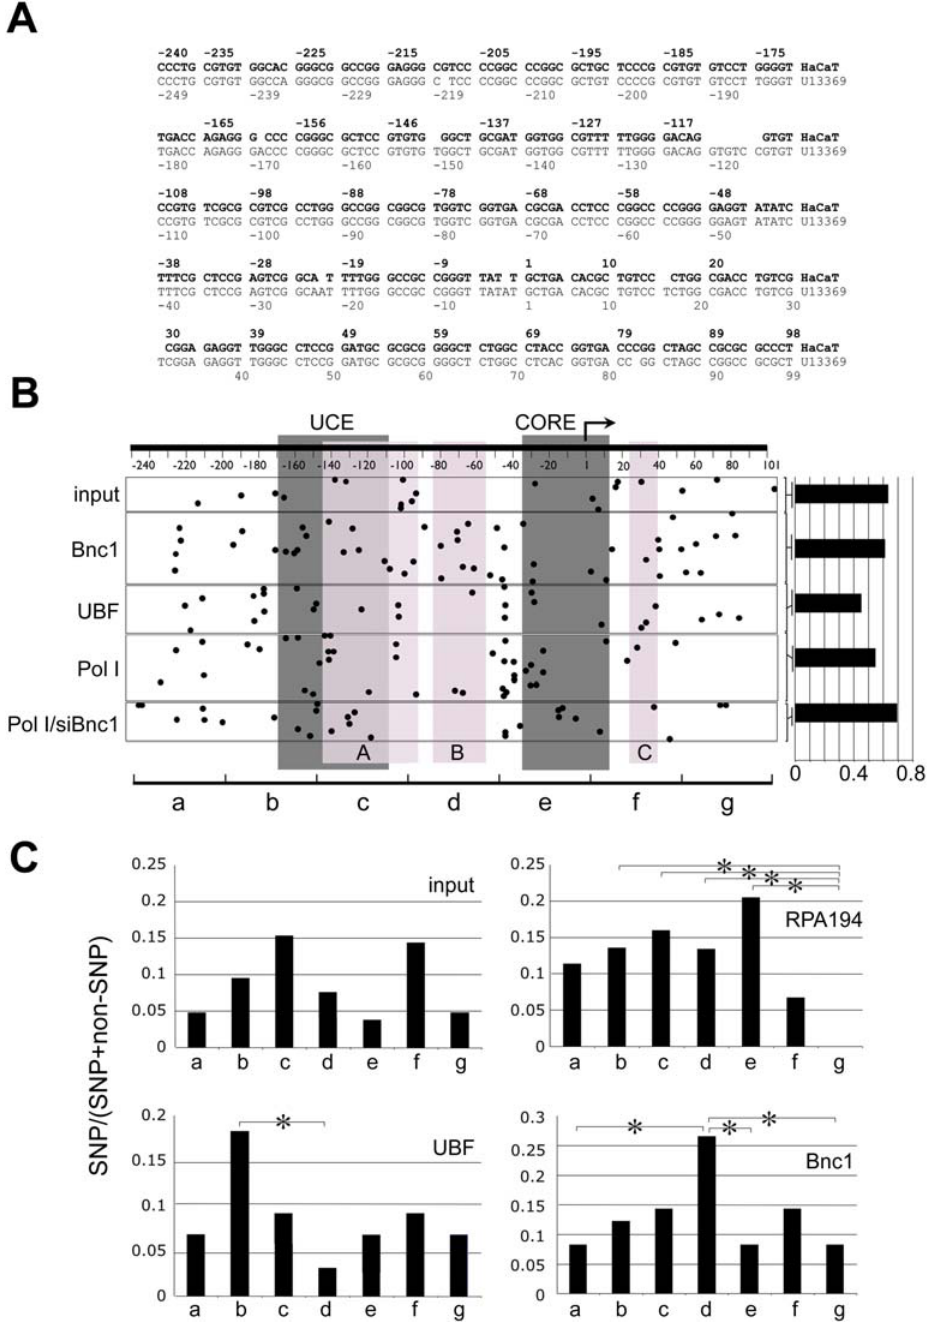
Figure 5. Single nucleotide polymorphism (SNP) in HaCaT rDNA promoters. A , A consensus DNA sequence of HaCaT cell rDNA promoters. The consensus (in bold letters) was deduced from the sequence of 181 HaCaT rDNA promoter clones, which were obtained from PCR-amplified rDNA promoters. Twenty-one of the clones were obtained directly from genomic DNA, the rest were isolated from ChIP DNA precipitated by anti- basonuclin (49 clones), anti-UBF (44 clones), anti-RFA194 in the presence (44 clones) and absence of basonuclin (23 clones). A human rDNA promoter sequence (U13369) is listed below the HaCaT consensus. The two sequences are aligned according to their transcription start site ( + 1). B , A tabulation of SNPs in various ChIP groups. A generic rDNA promoter is depicted at the top with transcription start site (bent arrow), and the cis elements (dark gray boxes) indicated. UCE, up-stream control element and CORE, the core element. Nucleotide coordinates are shown below the DNA. The three basonuclin binding sites (light gray boxes labeled A, B, C) are indicated. SNPs are depicted as dots. The horizontal position of each dot indicates its location in the rDNA promoter, and its vertical position, the ChIP groups as indicated on the left. Input, a collection of randomly picked genomic rDNA promoters, Bnc1-, UBF- and RPA194- (Pol I) associated promoters; Pol I/siBnc1, RPA194-associated promoters in basonuclin-deficient cells. Not all clones contained SNP and the percentage of SNP-containing clones in each ChIP group is shown by a histogram on the right. For a statistical analysis of the SNP frequency, see Table 1. C , For analyzing the regional SNP variations, the promoter is divided into seven 50-base non-overlapping regions, which were named alphabetically, as indicated at the bottom of (B), a, 2 250 to 2 201, b, 200 to 149, etc. The regional SNP frequencies are plotted for the input and three ChIP groups, RPA194, UBF and Bnc1. Statistically significant differences are indicated (*, p , 0.05). doi:10.1371/journal.pone.0000902.g005 PLoS ONE |